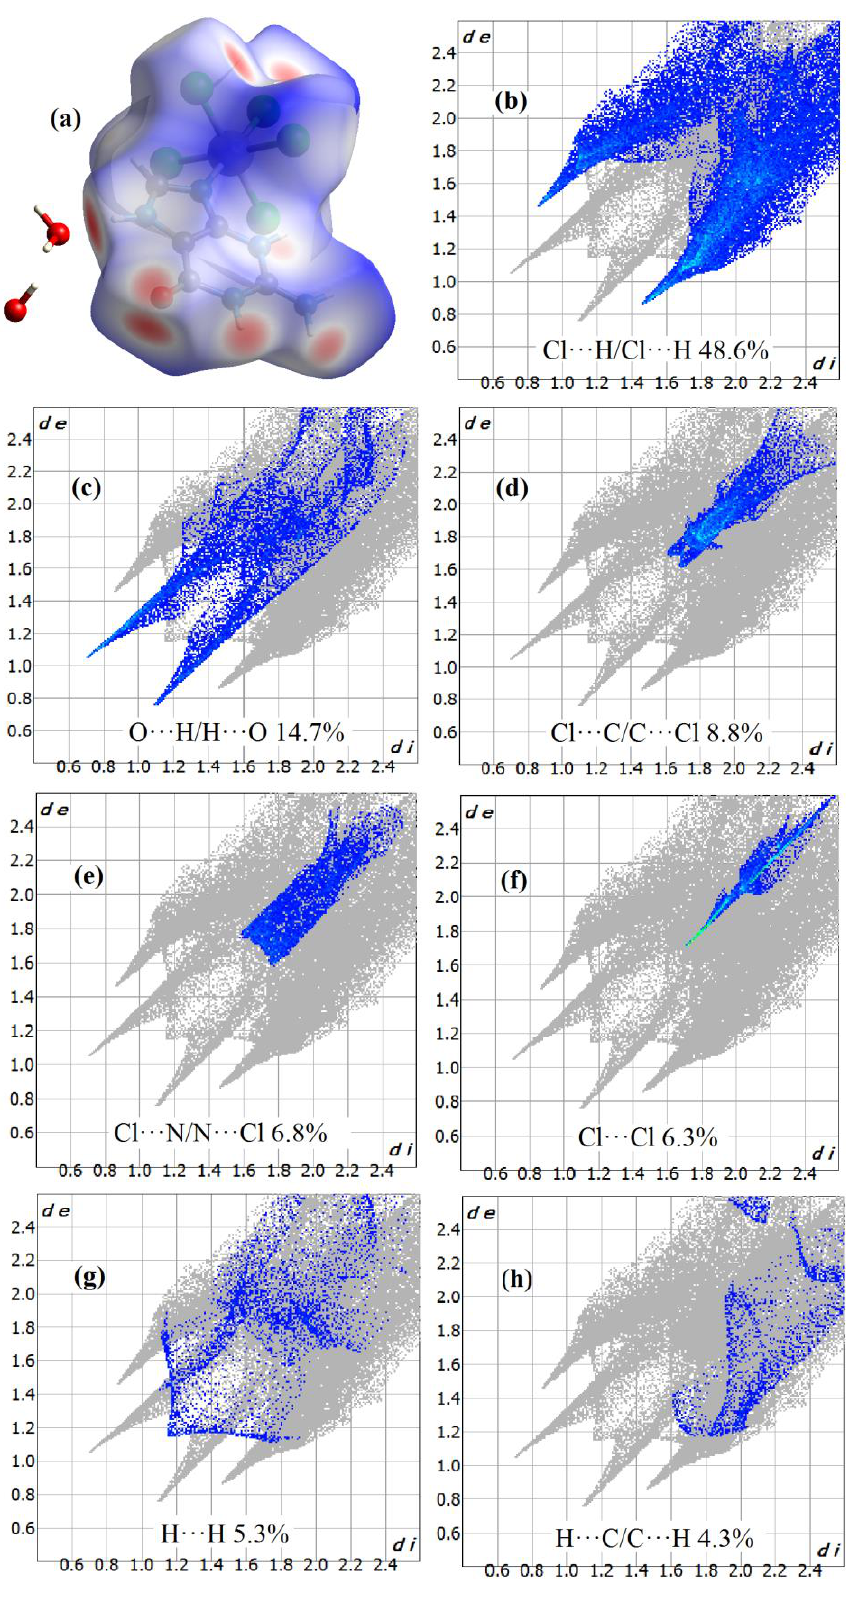
Figure 6. ( a ) Hirshfeld surface d norm for complex 2 and ( b ) two-dimensional fingerprint plot for Cl · · · H/H · · · Cl, ( c ) O · · · H/H · · · O, ( d ) Cl · · · C/C · · · Cl, ( e ) Cl · · · N/N · · · Cl, ( f ) Cl · · · Cl, ( g ) H · · · H, ( h ) H · · · C/C · · · H contacts. Surface color scale: red (distances shorter than sum of vdW radii), through white to blue (distances longer than sum of vdW